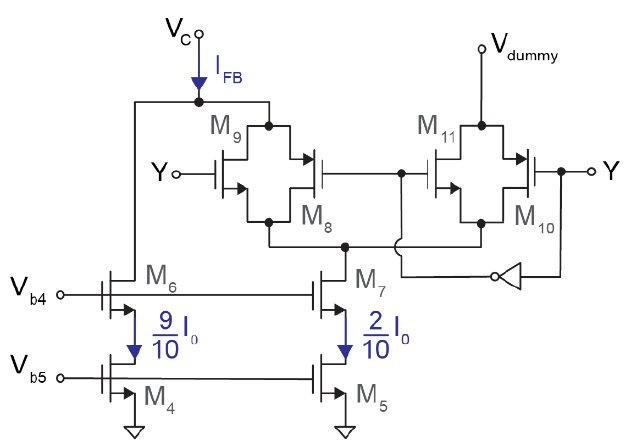
Figure 4. Schematic of the 1-bit feedback IDAC. A first current source (M 4 ) provides 0.9 · I 0 to the output, while the current generated by a second current source (M 5 ) is injected into the output or discarded depending on the state of Y.